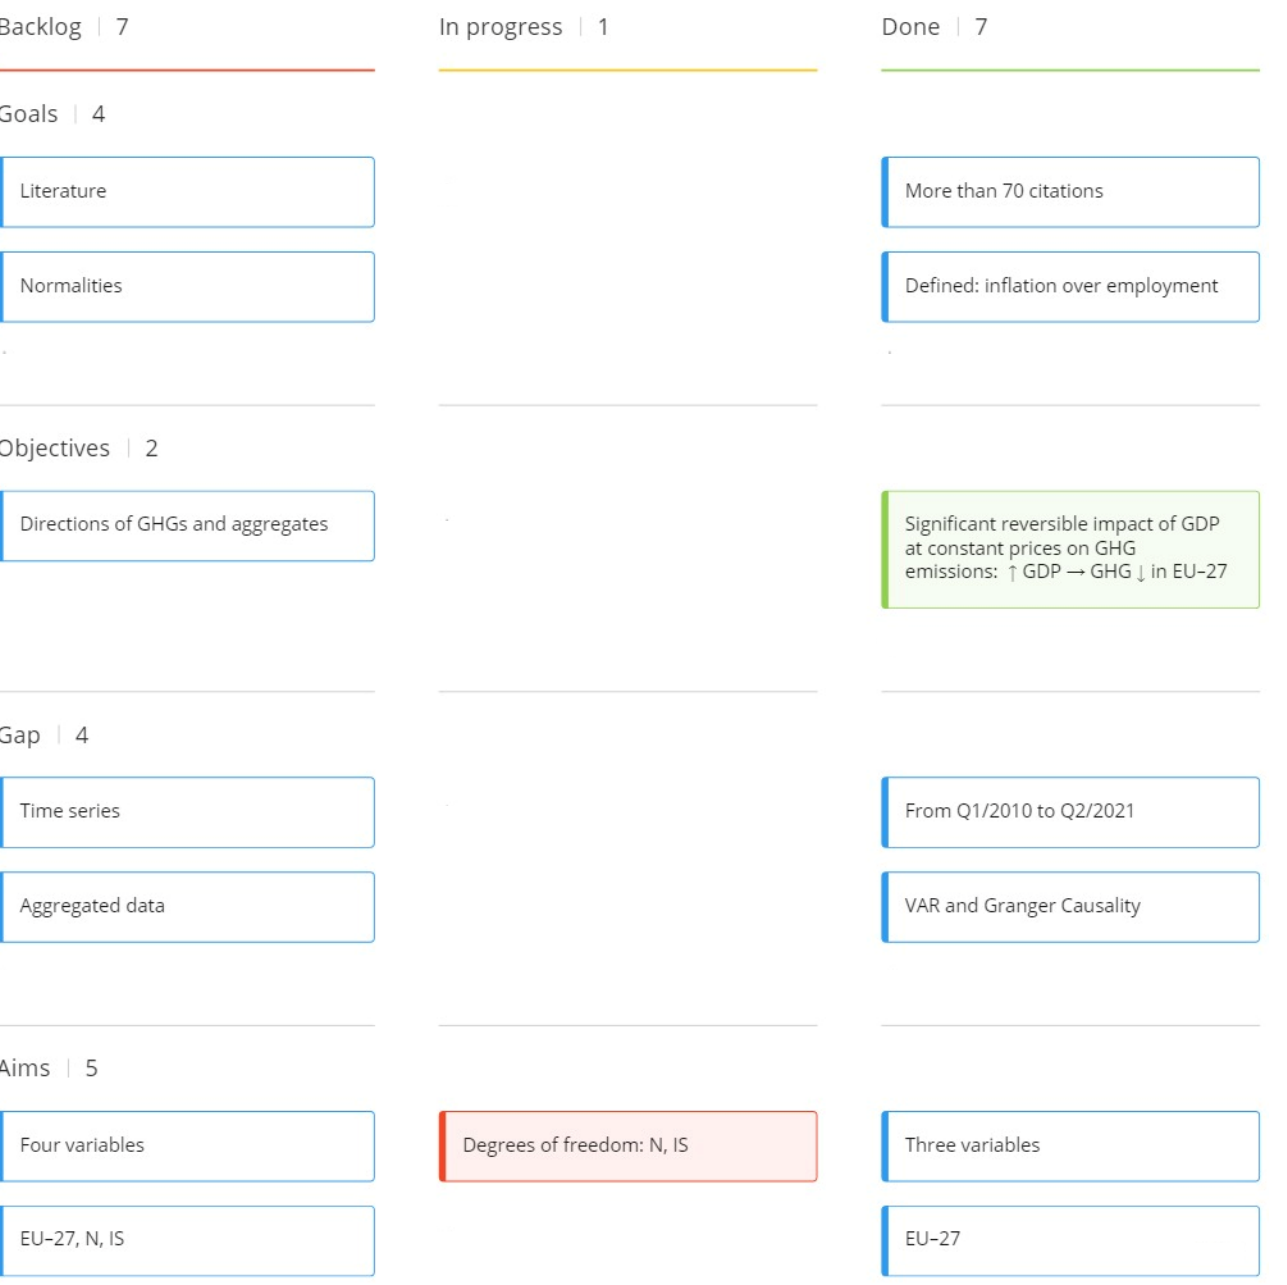
Figure 5. The key findings of the study. Note: EU-27—27 European Union countries, N—Norway, IS—Iceland, GDP—GDP at constant prices, GHG—air emissions accounting for greenhouse gases, VAR—vector autoregressive model. Source: Authors’ compilation.